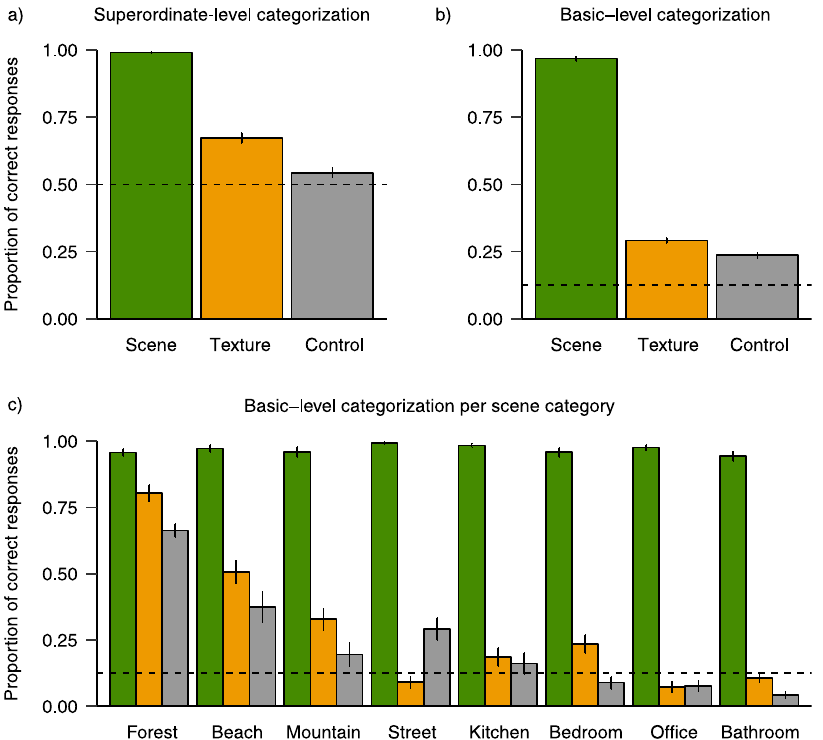
Figure 3. Proportion of correctly categorized scenes, textures, and colour controls for superordinate categorization ( a ) basic-level categorization ( b ) and basic-level categorization per scene category ( c ). Error bars depict the standard error of the mean. Dashed lines indicate chance